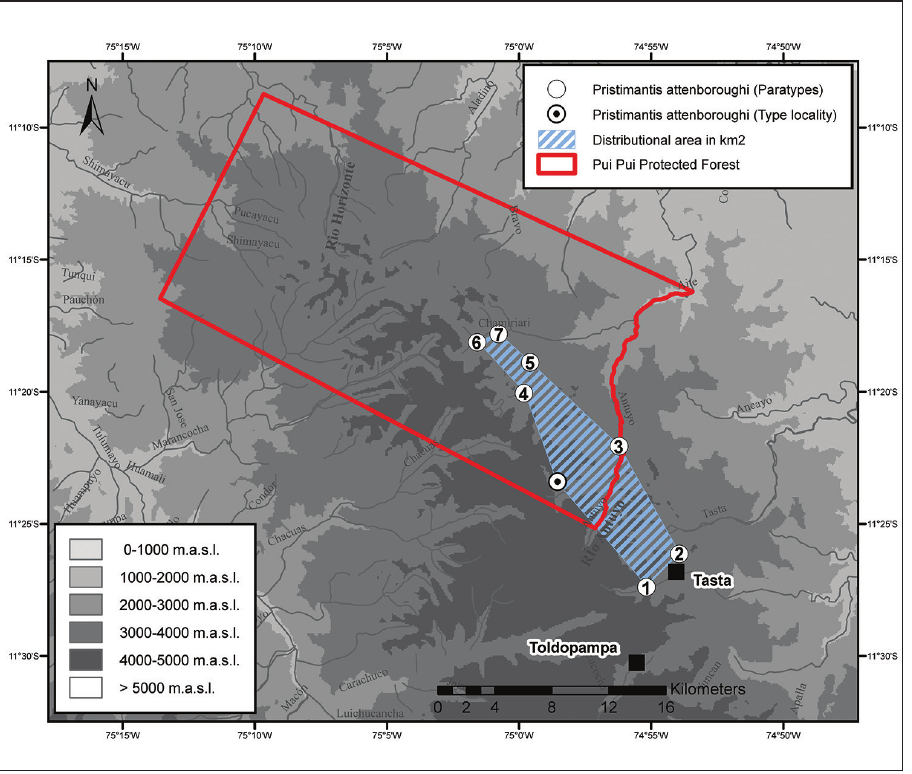
Figure 9. Distribution of Pristimantis attenboroughi sp. n. in the PPPF and its surroundings: type local- ity: Laguna Udrecocha, 3936 m a.s.l.; 1 Upper part of Quebrada Tasta, “Laguna Luichococha”, 3708